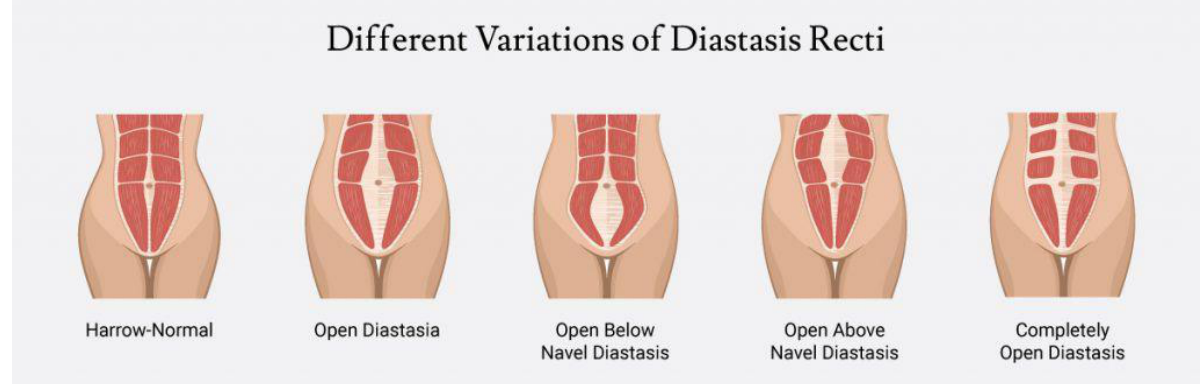
Figure 4. Diastasis Recti at different locations